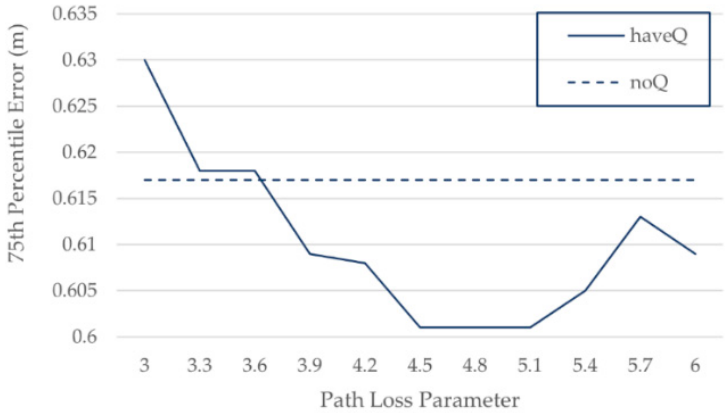
Figure 6. Positioning error of different noise standard deviations on simulated data.